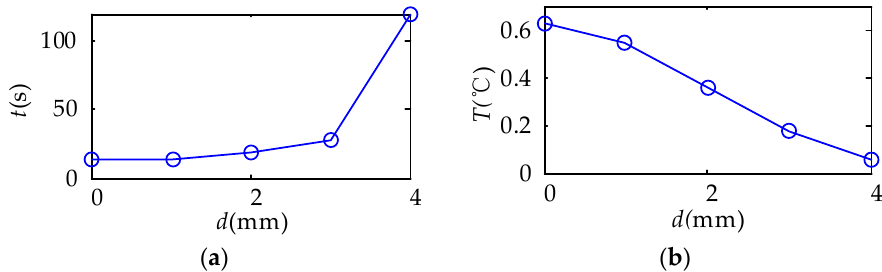
Figure 19. The relationships between the surface temperature difference curves and the depth of damages location. ( a ) The relationships between time of maximum surface temperature difference and the depth of damages location; ( b ) the relationships between maximum surface temperature difference and the depth of damages location.